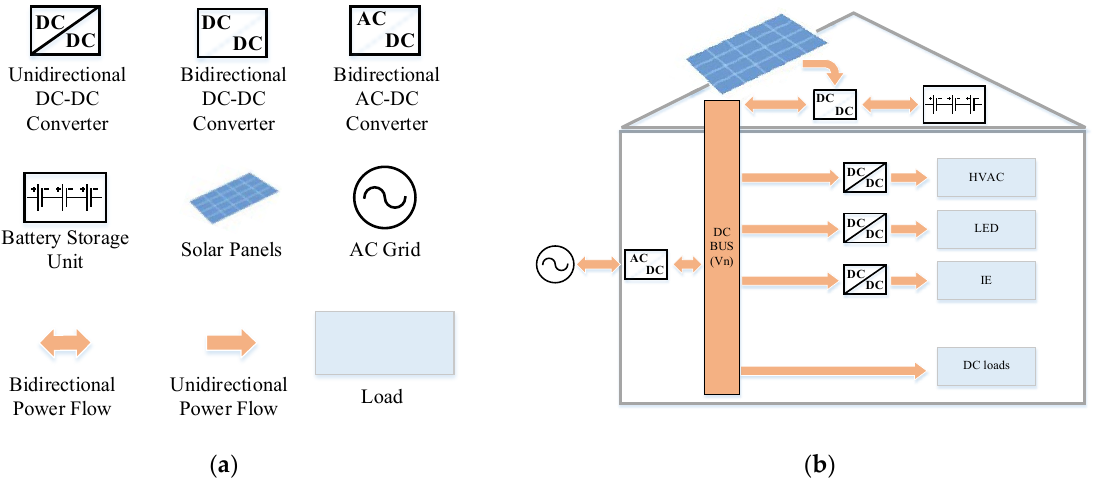
Figure 1. DC-RNG structure and components: ( a ) symbol guide, ( b ) structure.